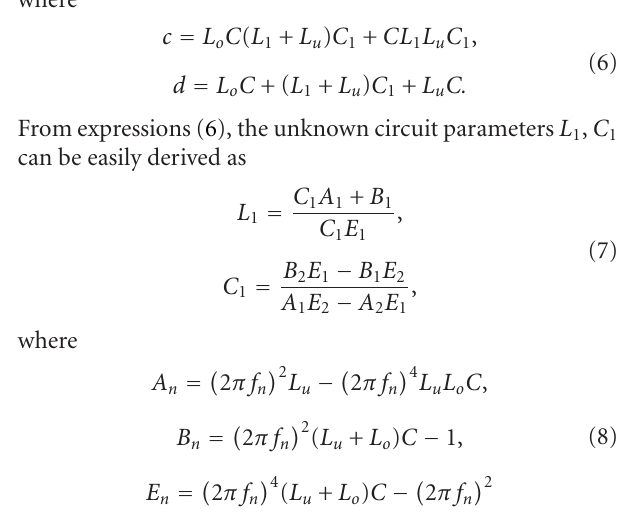
reflectarray patches and the grid spacing D between adjacent elements.